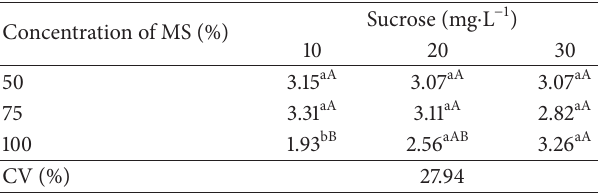
Table 7: Height of sweet potato plant shoots at 270 days of in vitro conservation under 18 ∘ C, depending on genotype and variations in the salt MS medium and sucrose.